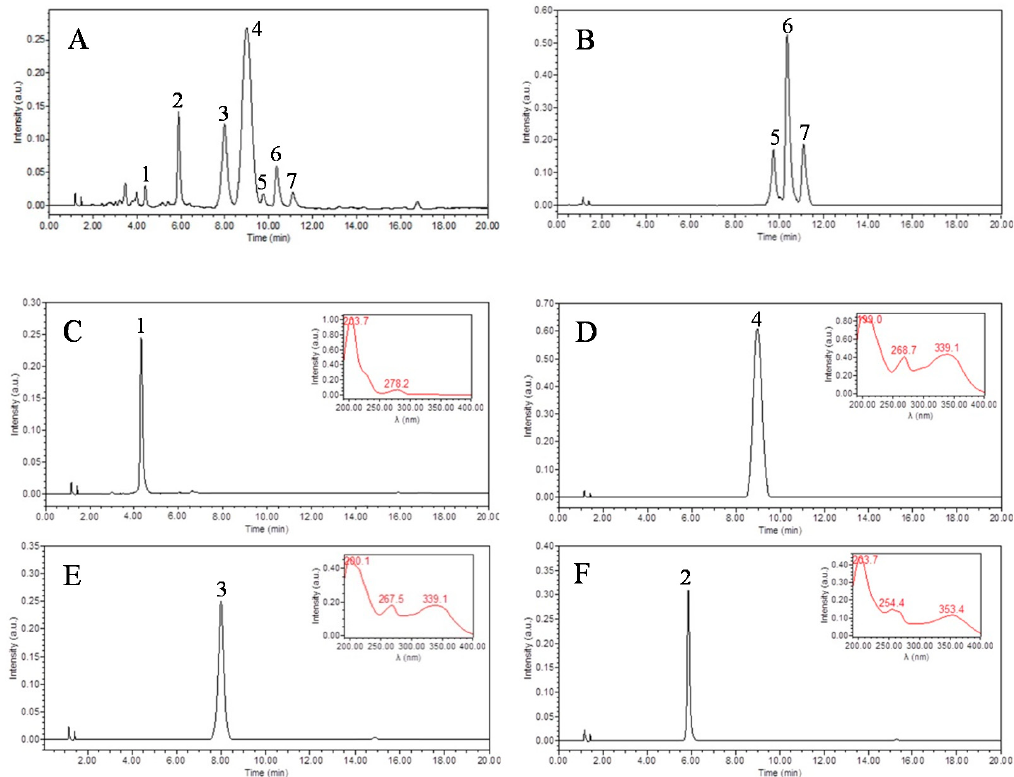
Figure 3. HPLC chromatograms of HSCCC fractions. ( A : purchased total flavonoids; B : peak I in Figure 2; C : peak II in Figure 2; D : peak III in Figure 2; E : peak IV in Figure 2; F : peak V in Figure 2.) Experimental conditions: a Waters XBridge BEH C 18 column (100 mm × 4.6 mm i.d., 2.5 μ m); Flow